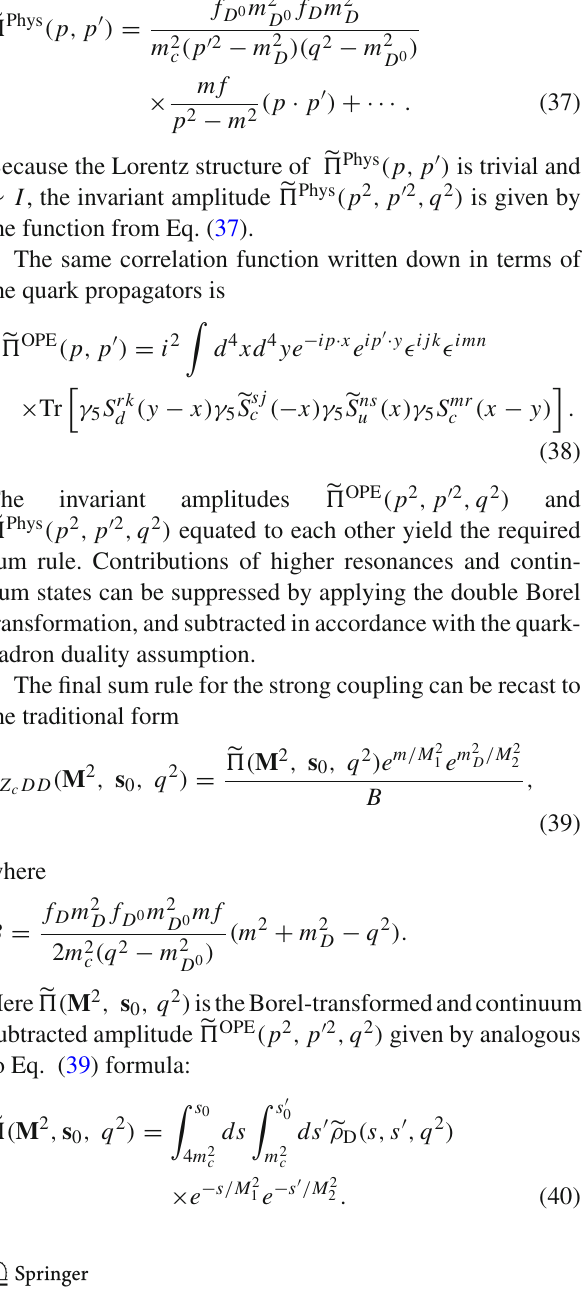
Table 1. Constraints imposed on the auxiliary parameters M 2 and s 0 aresimilartoonesdiscussedaboveanduniversalforall and s 0 coincide sum rules computations.The parameters M 2 1 with the working regions for these parameters fixed in the mass calculations (14). The Borel and continuum threshold , s (cid:4) in Eq. (40) parameters M 2 2 0